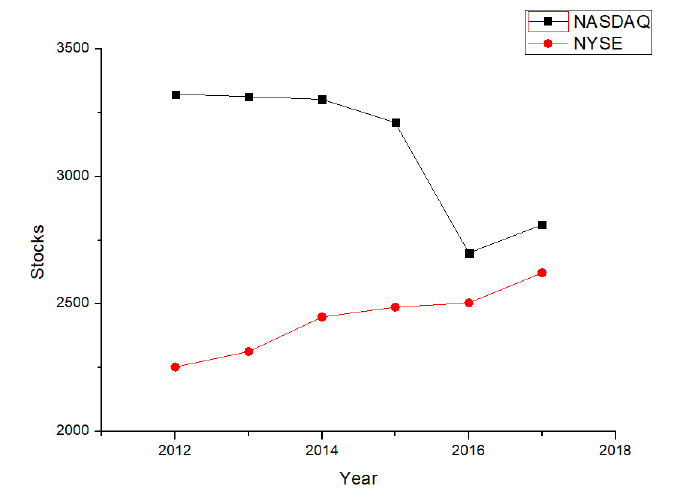
Figure 8. Stocks in the market,